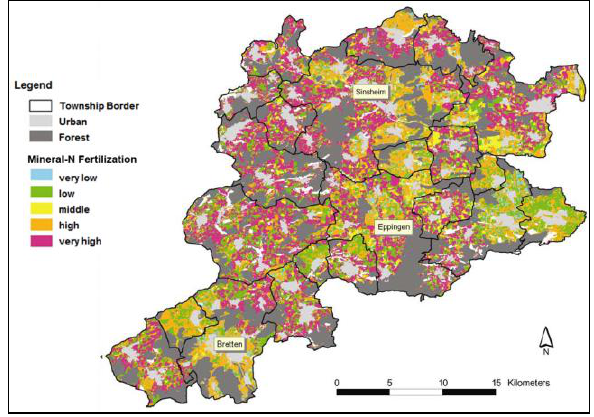
Figure 7. Mineral N-input (Rohierse,